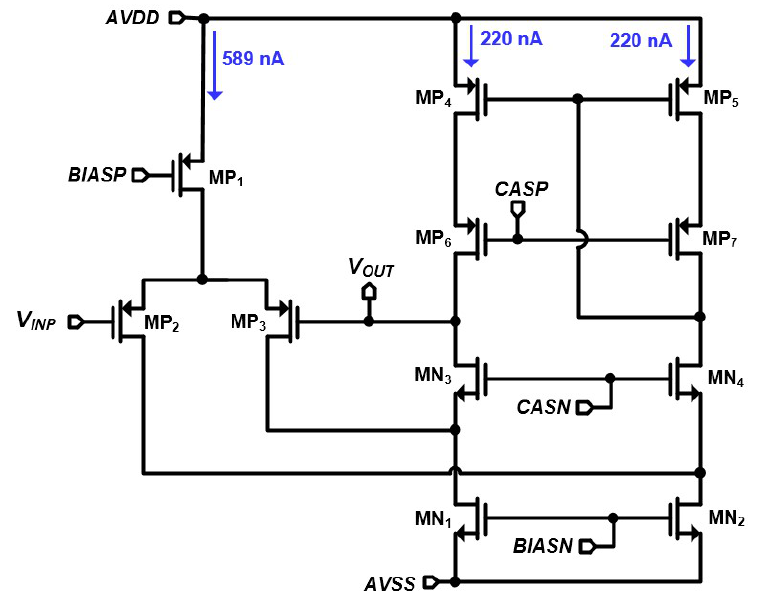
Figure 6. Schematic of the buffer.